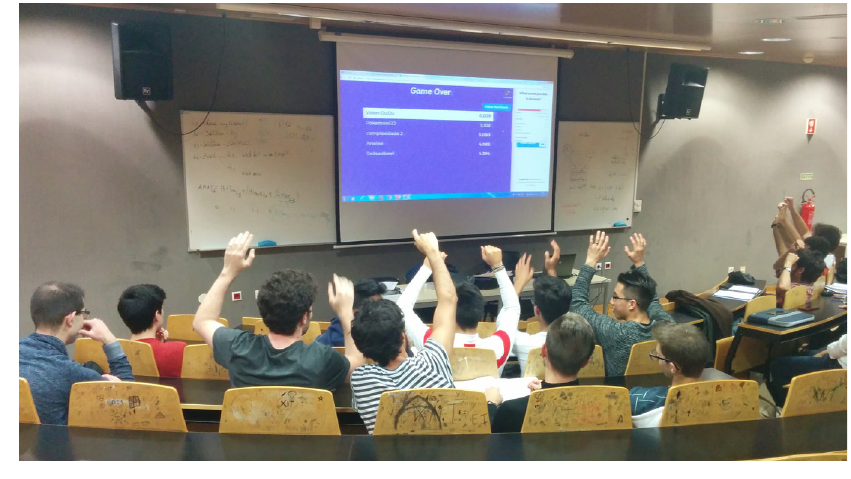
Fig. 6. Students behaviour at the Kahoot